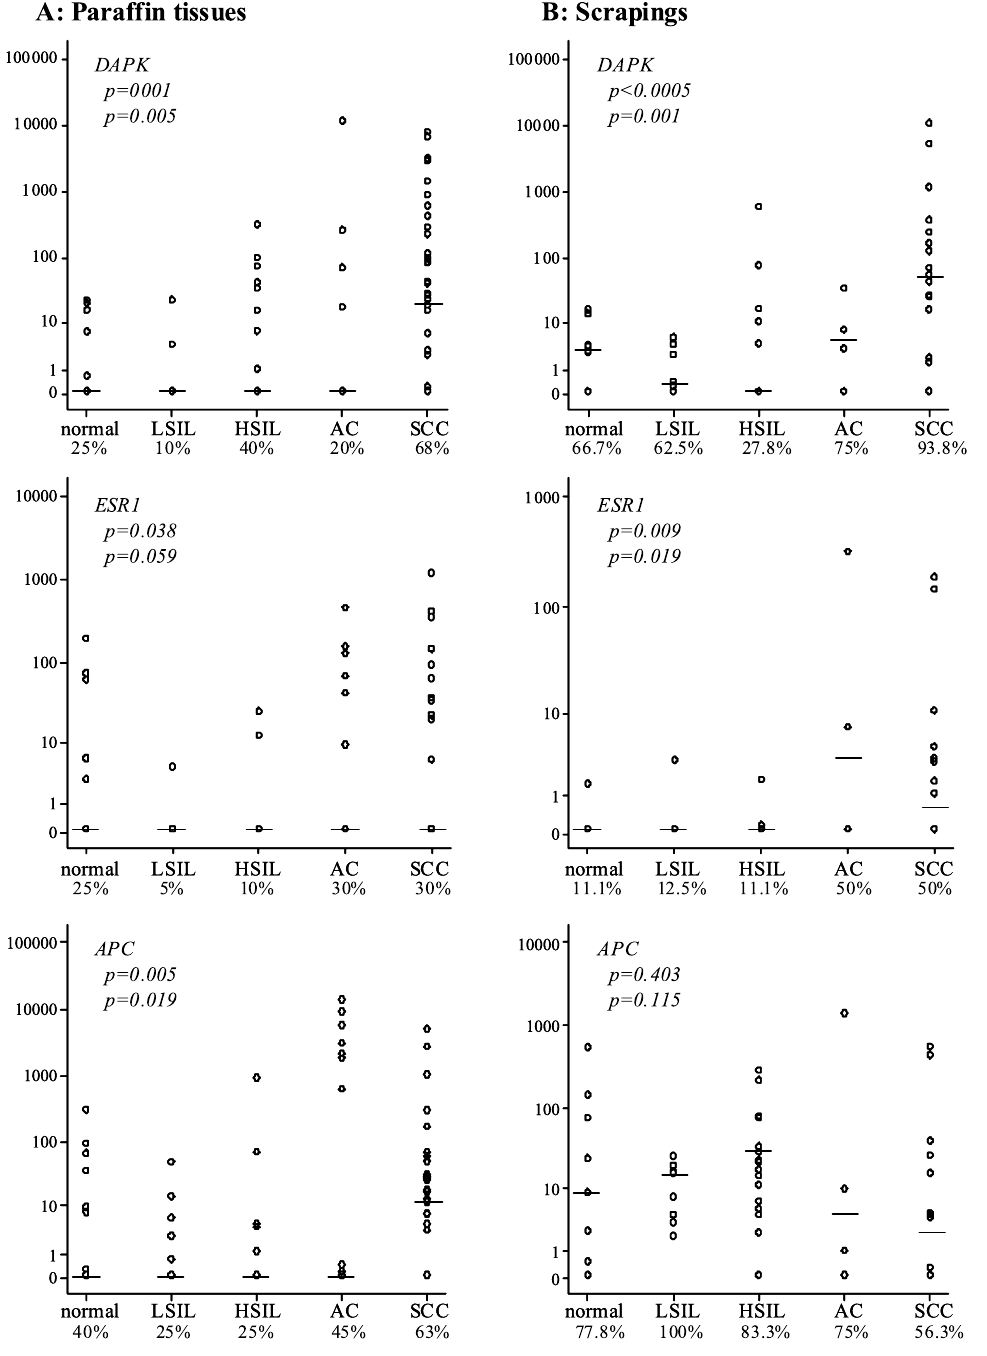
Fig. 1. Methylation ratio and frequency of positive methylation samples of nine gene promoters in normal cervices, LSIL, HSIL and cervical cancer lesions. On the left-hand side (A) methylation is shown determined in the paraffin embedded tissue of normal ( n = 20), LSIL ( n = 20), HSIL ( n = 20), AC ( n = 20) and SCC ( n = 40) and on the right-hand side (B) the methylation is shown determined in the scrapings of normal ( n = 9), LSIL ( n = 8), HSIL ( n = 18), AC ( n = 4) and SCC ( n = 16). The bars represent the median methylation ratio. p -values are shown for the calculation of the methylation ratio and methylation frequency in relation with severity of the lesion by respectively Kruskall–Wallis (upper) and χ 2 (lower) statistics. a No statistics are computed because CALCA was methylated in all